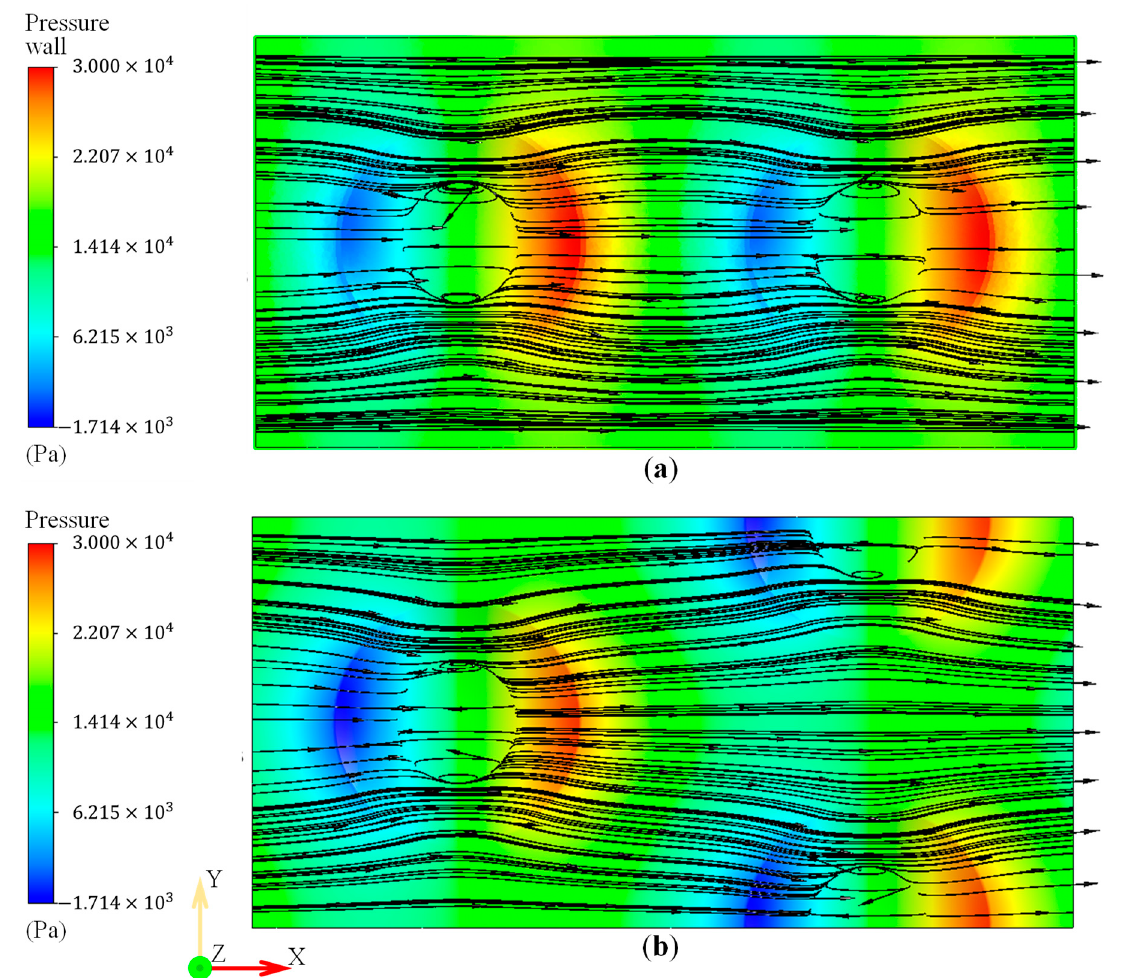
Figure 24. Streamlines and pressure (coloured contours) distributions around the die surface: ( a ) grid array pa tt ern; ( b ) crossing array pa tt ern.